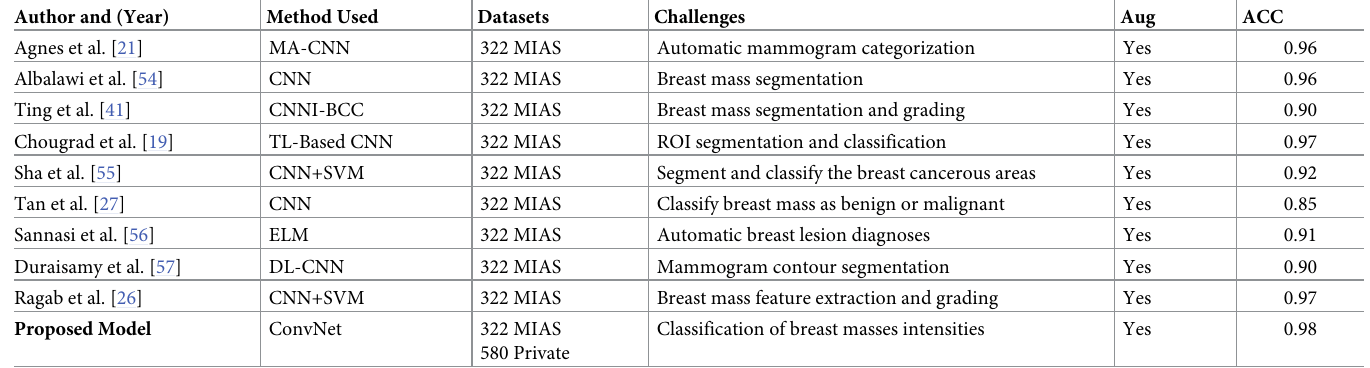
Table 5. Comparison of proposed approach with state-of-the-art conventional schemes in terms of accuracy rate. The experimental findings demonstrate the effective- ness of the suggested approach, with an overall training 0.98 accuracy. Author and